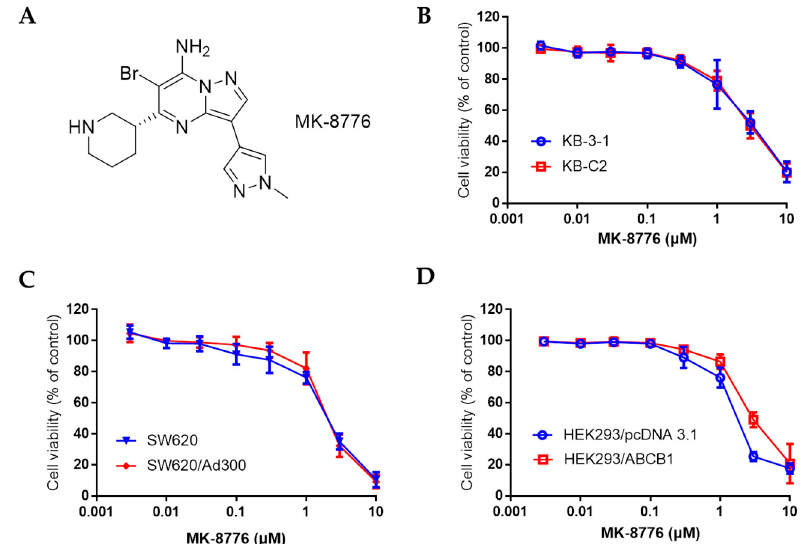
Figure 1. The chemical structure of MK-8776 ( A ), and the cell viability curve of human epidermoid carcinoma cell line KB-3-1 and its drug resistant KB-C2 cells ( B ), colon cancer cell line SW620 and doxorubicin-resistant SW620 / Ad300 cells ( C ) that overexpress P-gp, HEK293 / pcDNA3.1 and ABCB1 transfected HEK293 / ABCB1 cells ( D ) upon treatment with MK-8776.